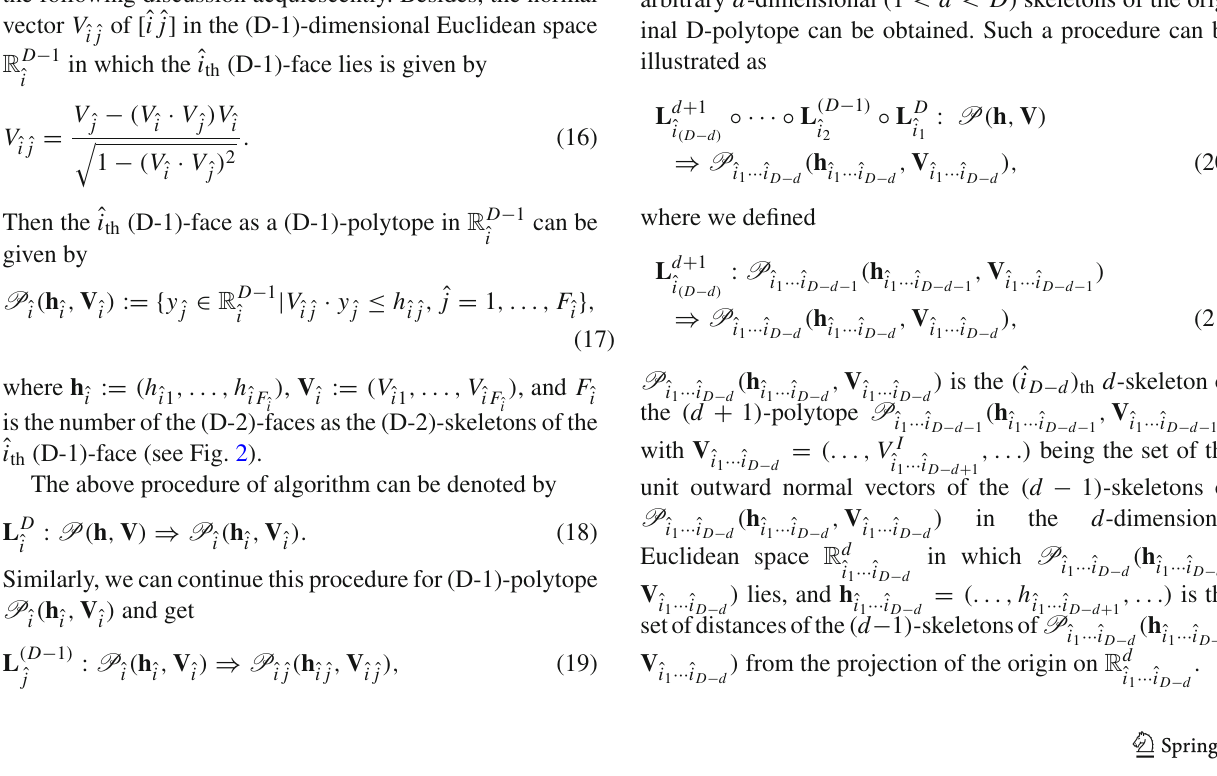
Fig. 2 The ˆ i th and ˆ j th (D-1)-faces in the D-polytope P ( A , V ) . The point O represents the origin of R D where P ( A , V ) lies, and the point O ˆ represents the projection of O on R D − 1 ˆ . p is a point in the ˆ i th (D- i i 1)-face which can be denoted by x in the coordinate system in R D with origin O or by y ˆ in the coordinate system in R D − 1 ˆ with origin O ˆ . [ ˆ i ˆ j ] i i i is the intersection set of ˆ i th and ˆ j th (D-1)-faces, V ˆ is the normal vector i ˆ j of [ˆ i ˆ j ] in R D − 1 ˆ , and h ˆ is the distance of [ˆ i ˆ j ] from the origin O ˆ i ˆ j i i ( h , V ) is the ˆ j P ( h , V ) , where P ˆ ˆ i ˆ j ˆ i ˆ j ˆ i ˆ i ˆ i th (D-2)-face of i ˆ j = (. . . , V I , . . .) is the set of the unit outward normal V ˆ ˆ i ˆ j ˆ j (cid:13) i ˆ j ( h , V ) in the (D-2)- vectors of the (D-3)-skeletons of P ˆ ˆ i ˆ j ˆ i ˆ j i ˆ j − 2 ( h , V ) dimensional Euclidean space R D in which P ˆ ˆ i ˆ j ˆ i ˆ j ˆ i ˆ j i ˆ j = (. . . , h , . . .) is the set of distances of lies, and h ˆ ˆ i ˆ j ˆ j (cid:13) i ˆ j ( h , V ) from the projection of the (D-3)-skeletons of P ı ˆ j ı ˆ j ı ˆ j − 2 the origin on R D ˆ i ˆ